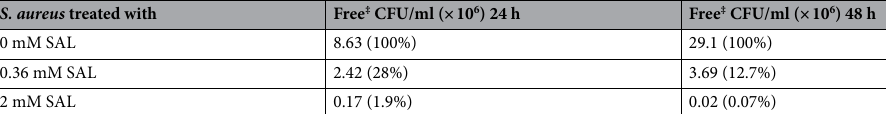
S. aureus treated